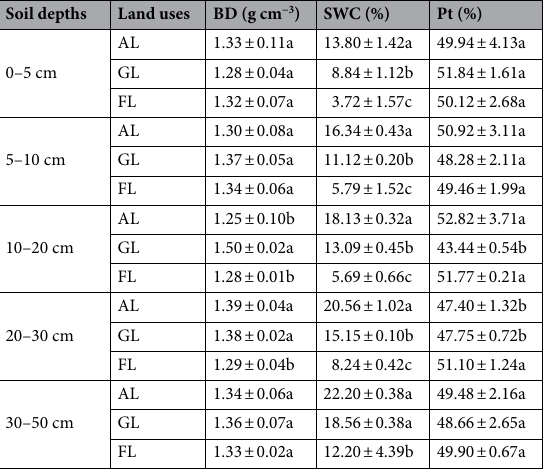
Table 1. Soil water content (SWC), soil bulk density (BD) and total soil porosity (P t ) among different land uses (mean ± SD). Different letters at the same soil depth indicate significant difference (n = 5, p < 0.05) among different land uses by one-way